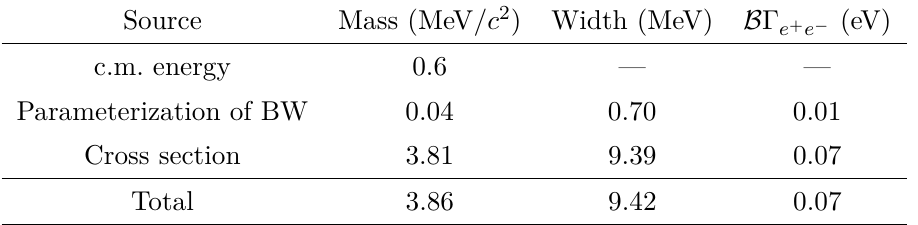
Table 7 . The systematic uncertainties for the resonance parameters with the single BW